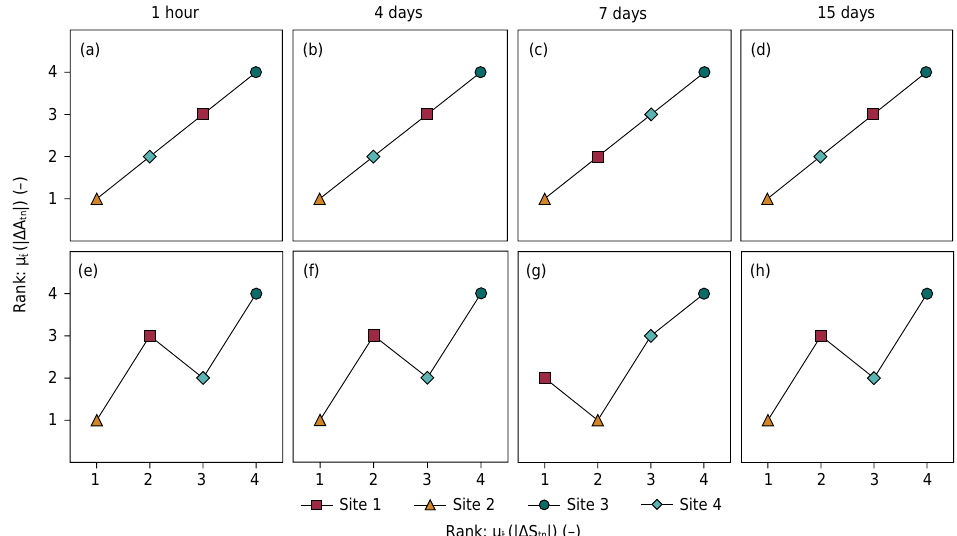
Figure 7. Scatter plots of absolute temporal mean ranking of absolute soil moisture differences [|μ t ̂ (ΔS tn )|] against the temporal mean ranking of absolute SM temporal mean differences μ t ̂ (|ΔM tn |) (a, b, c, and d) and temporal mean ranking of absolute temporal anomaly differences μ t ̂ (|ΔA tn |) (e, f, g, and h).